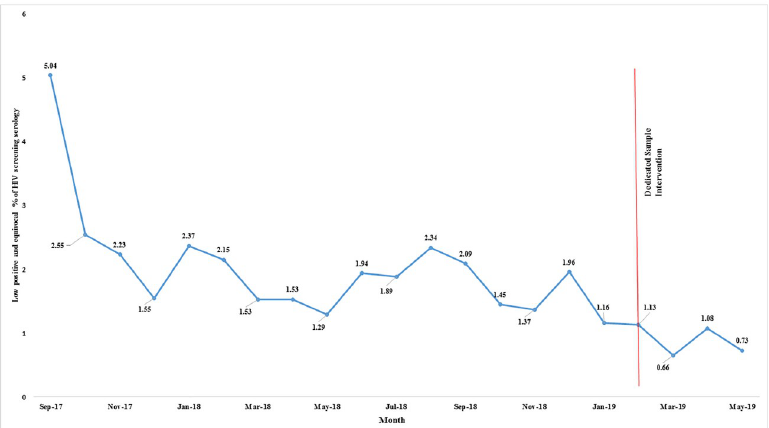
contamination on the analyser.